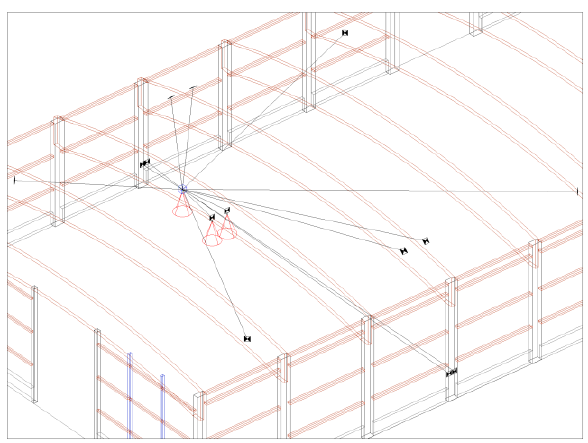
Figure 3. The 3D model of a machine hall and the target template.